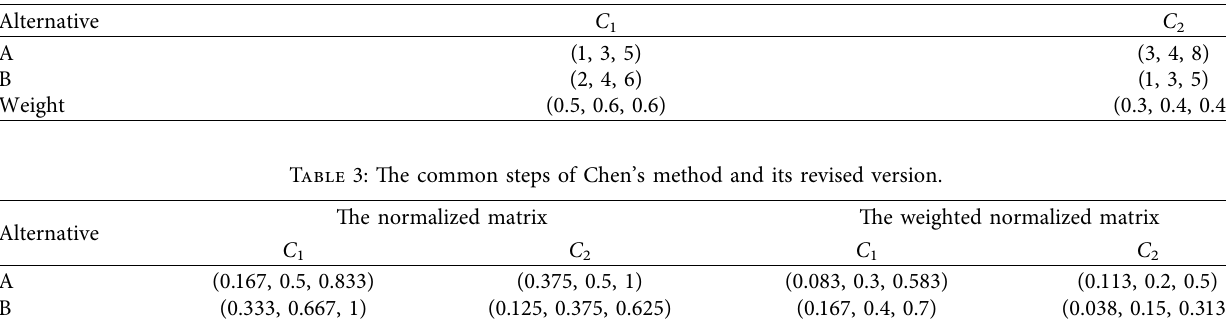
Table 2: Fuzzy triangular decision matrix.